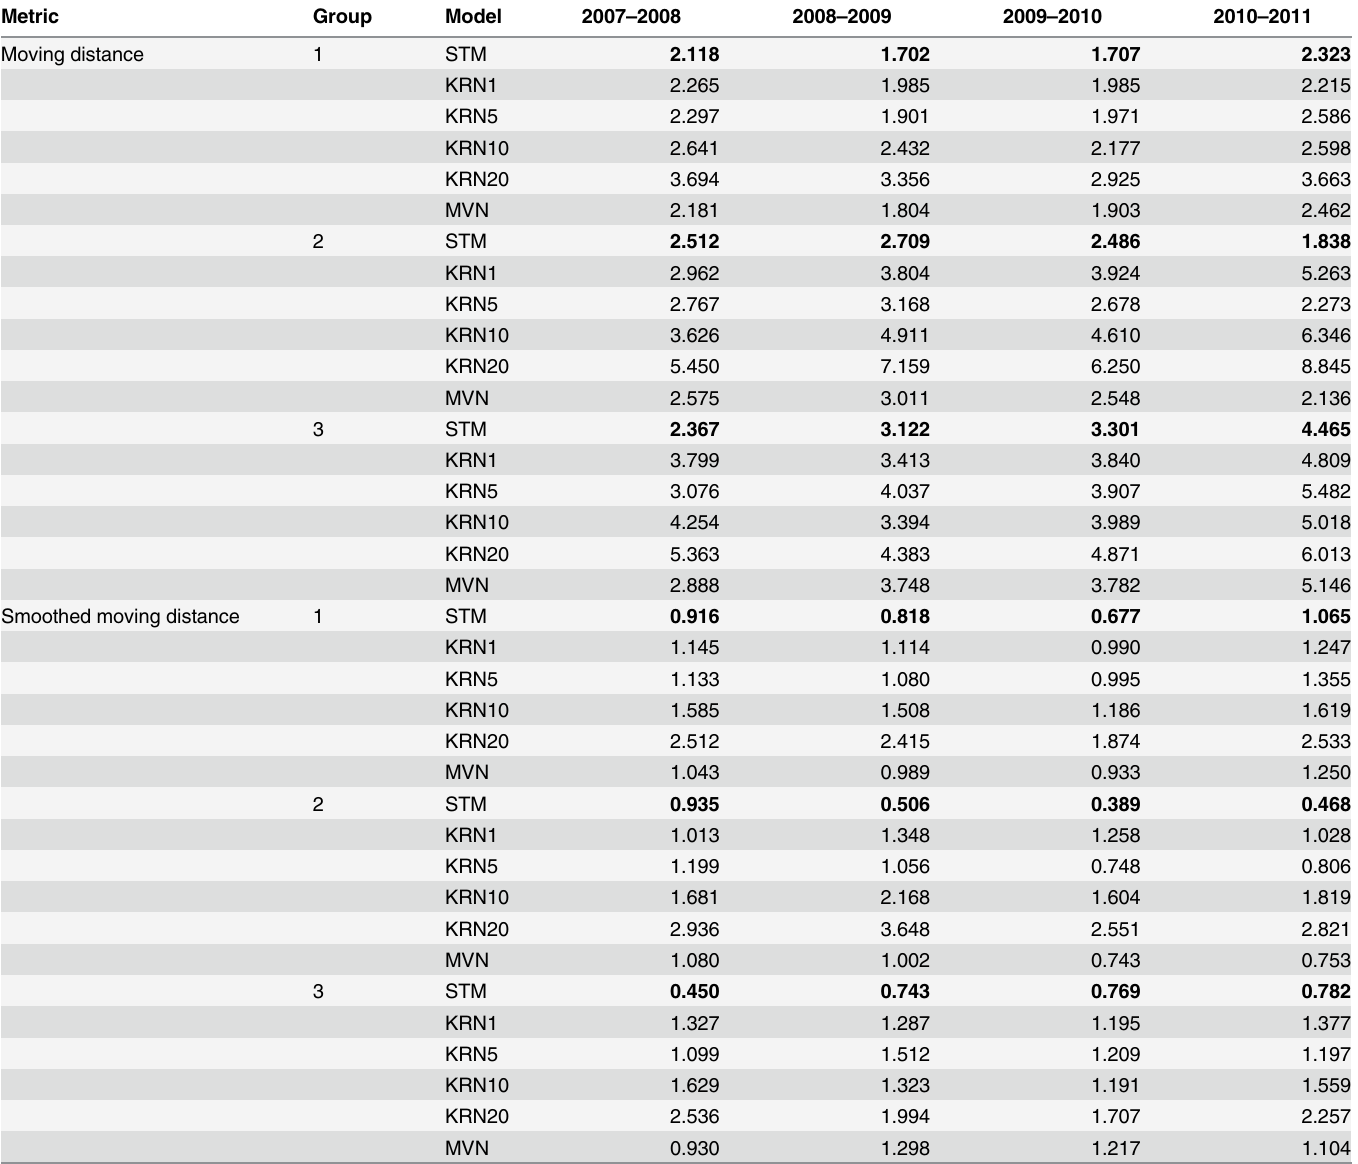
Table 4. The mean difference in the moving distance measure between the simulations and the data for the year. The numbers in bold indicate the best measure among the three models for each year. Metric Group Moving distance